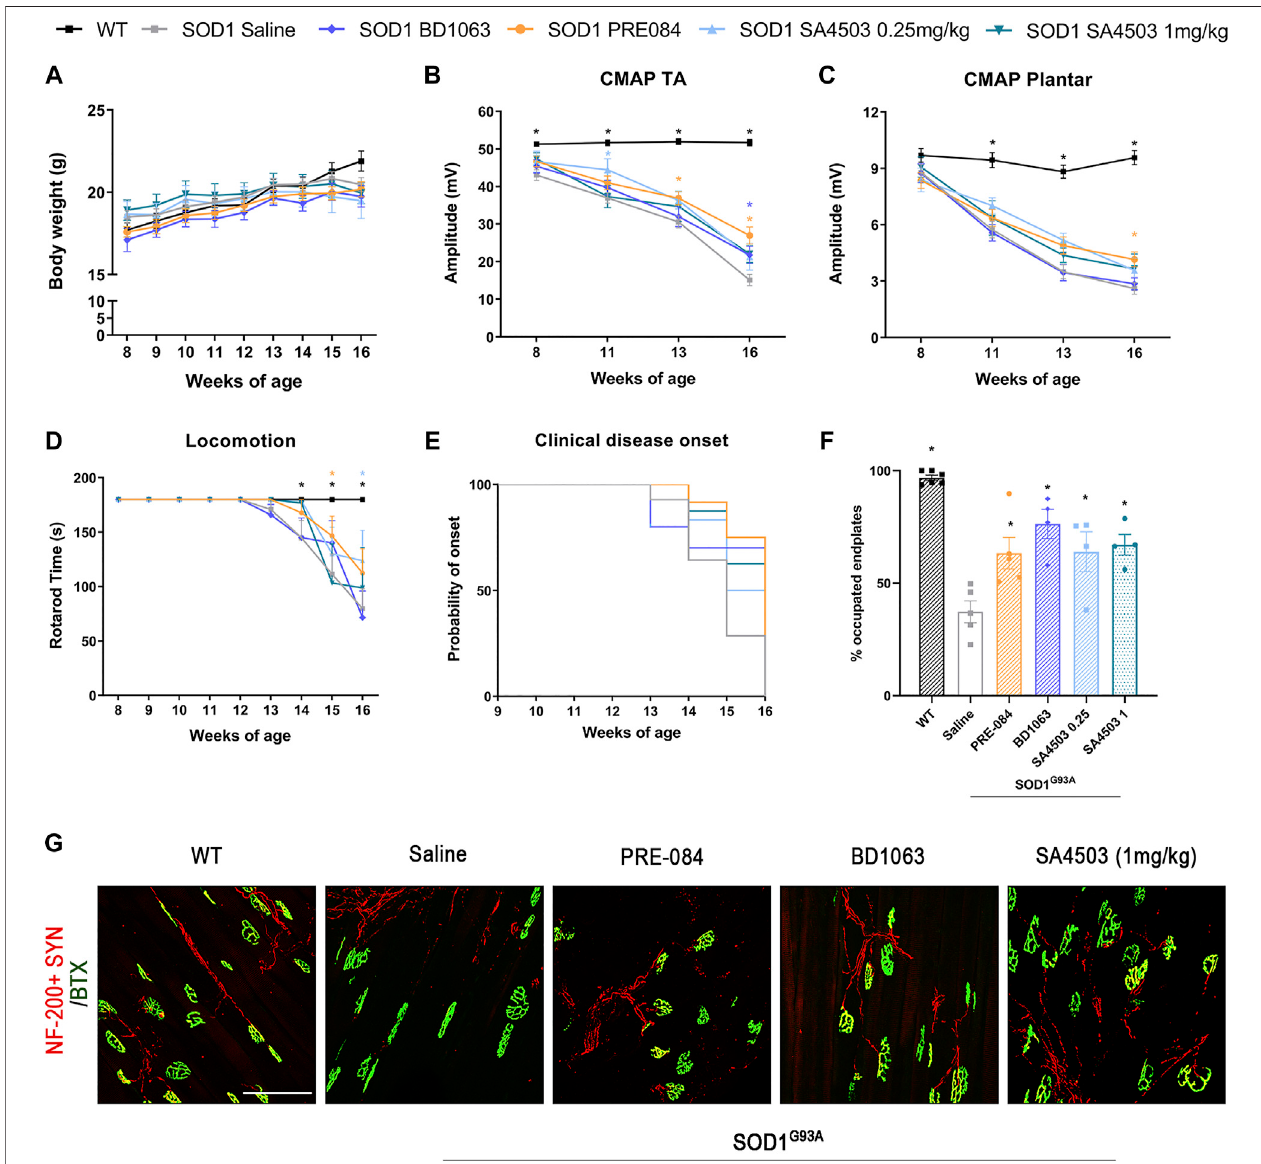
FIGURE 2 | Treatment with PRE-084, BD1063 and SA4503 enhances neuromuscular function in SOD1 G93A female mice (A) Body weight of mice was monitored weekly during the 8 weeks of the follow-up (B-C) Values of the amplitude of compound muscle action potentials (CMAP) of tibialis anterior (TA) and plantar interosseus muscles (D) Graph showing the effect of the different Sig-1R treatment on functional outcome assessed with the rotarod test (n (cid:1) 15 WT; n (cid:1) 15 SOD1 saline; n (cid:1) 12 SOD1 BD1063; n (cid:1) 7 SOD1 SA4503 0.25 mg/kg; n (cid:1) 7 SOD1 SA4503 1 mg/kg, and n (cid:1) 14 SOD1 PRE-084 mice) (E) Probability of clinical onset of disease evaluated by the fall in the rotarod test. Some Sig-1R ligands delayed the onset of locomotion de fi cits but without signi fi cant differences (F) Plot of the percentage of innervated NMJ (overlap of signals) in the different experimental groups (n (cid:1) four to six mice per group) (G) Representative confocal images of GA NMJs at 16 weeks of age. The maximum projection images shown were generated from 1.3 µm z projections. Scale bar 100 μ m. Data are mean ± SEM, analyzed by One-way (F) and Two- way (A-D) ANOVA with Bonferroni ’ s multiple comparisons test. * p < 0.05 vs SOD1 G93A saline